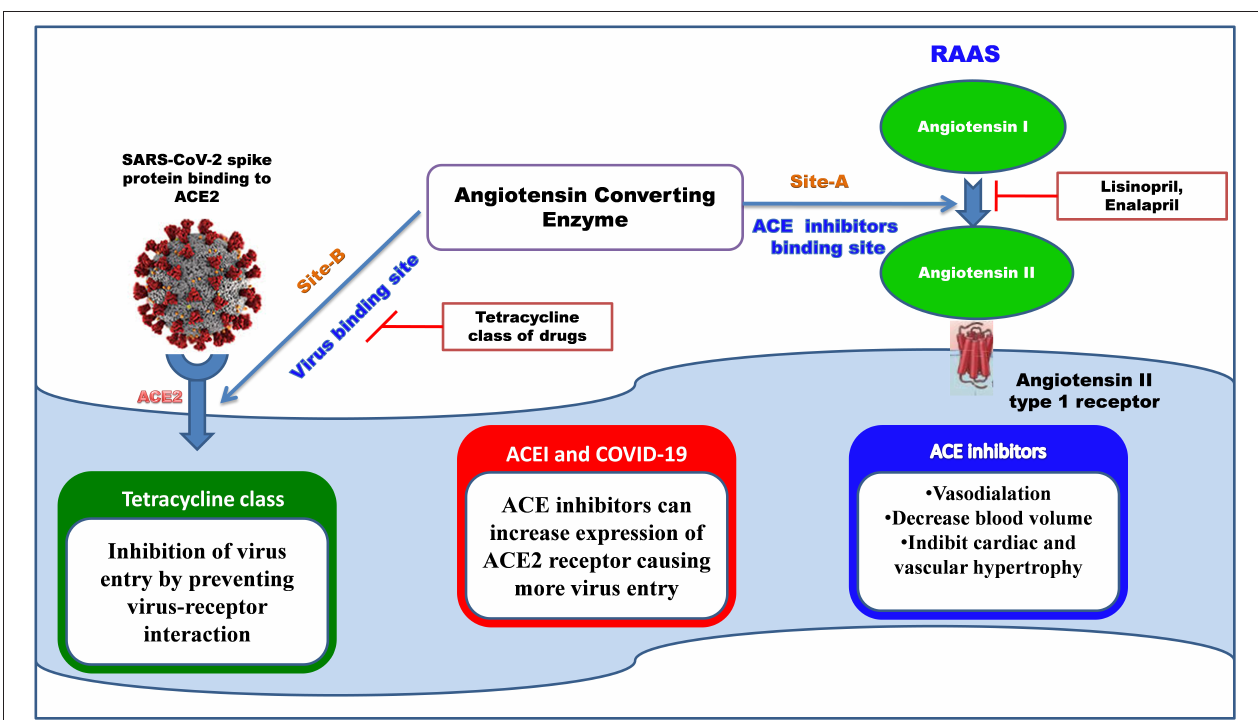
FIGURE 6 | The binding site of ACE inhibitors and SARS-COV2 spike